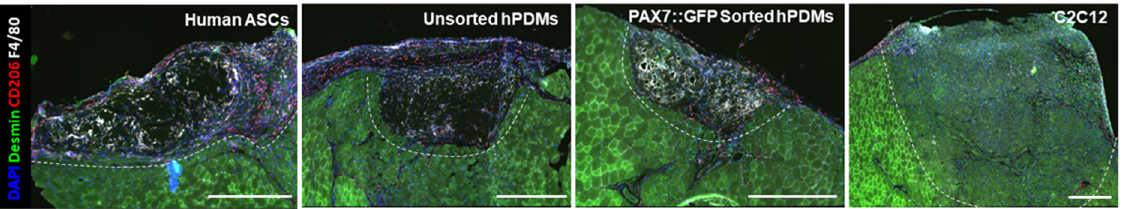
Figure 5. PAX7::GFP-Sorted hPDMs demonstrate moderate regeneration without distortion of native architecture. Human unsorted hPDMs demonstrate moderate regeneration of defect area but showed less organization and increased distortion and growth over native tissue relative to PAX7::GFP-sorted hPDMs. Regardless of human cell source, regeneration is characterized by a robust macrophage response. (scale bars: 500 µ